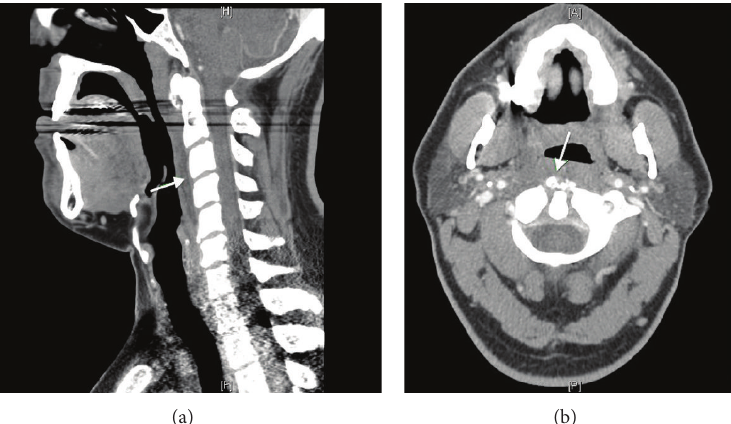
Figure 1: (a) Sagittal CT neck with IV contrast shows a prevertebral fluid collection (arrows). (b) Axial CT neck with calcifications of the longus coli tendon (arrow).